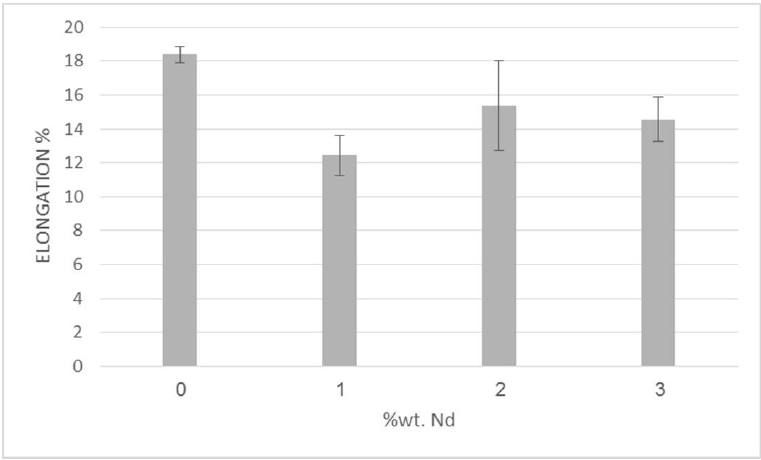
Figure 6. Tensile elongation of tested Alloys vs. Nd content. Table 3. Hardness measurements of all the tested alloys.